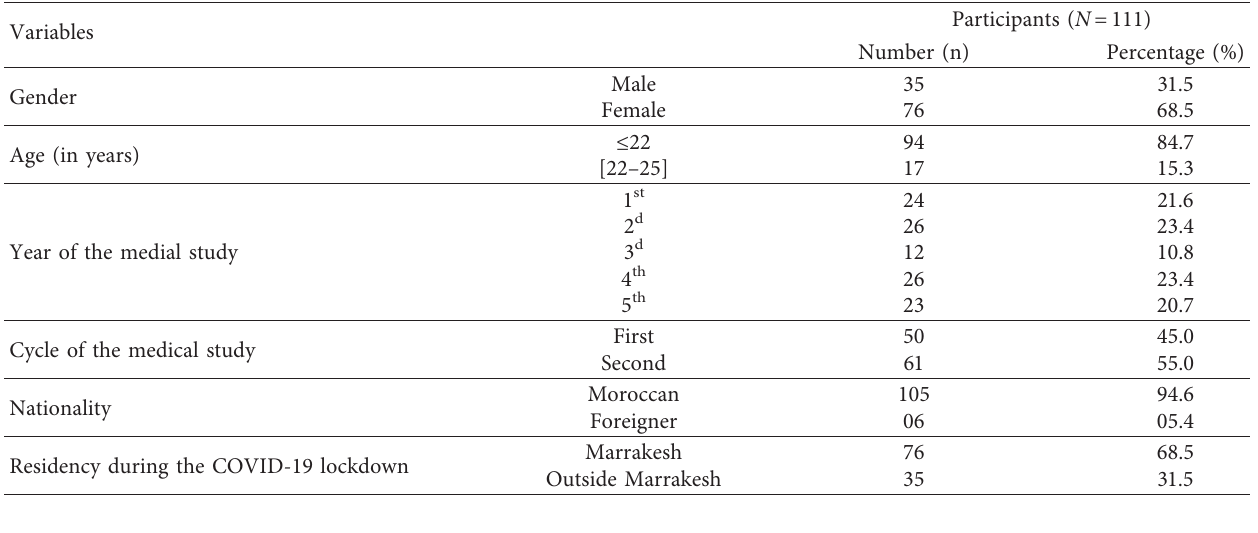
Table 1: Participants’ sociodemographic characteristics.